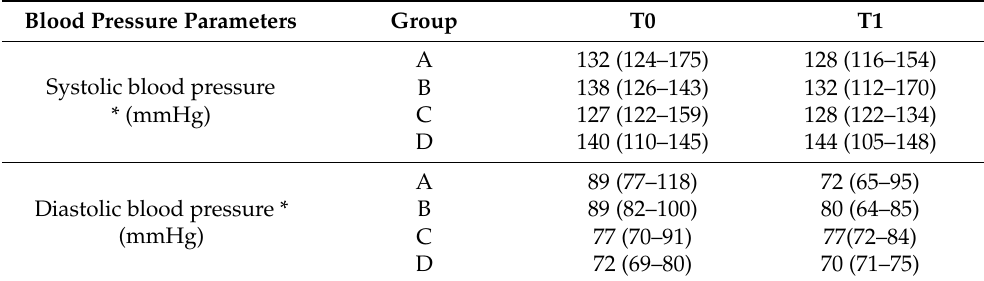
Table 4. Blood pressure parameters of the study population divided according to treatment group. * This parameter is represented as median (minimum-maximum).